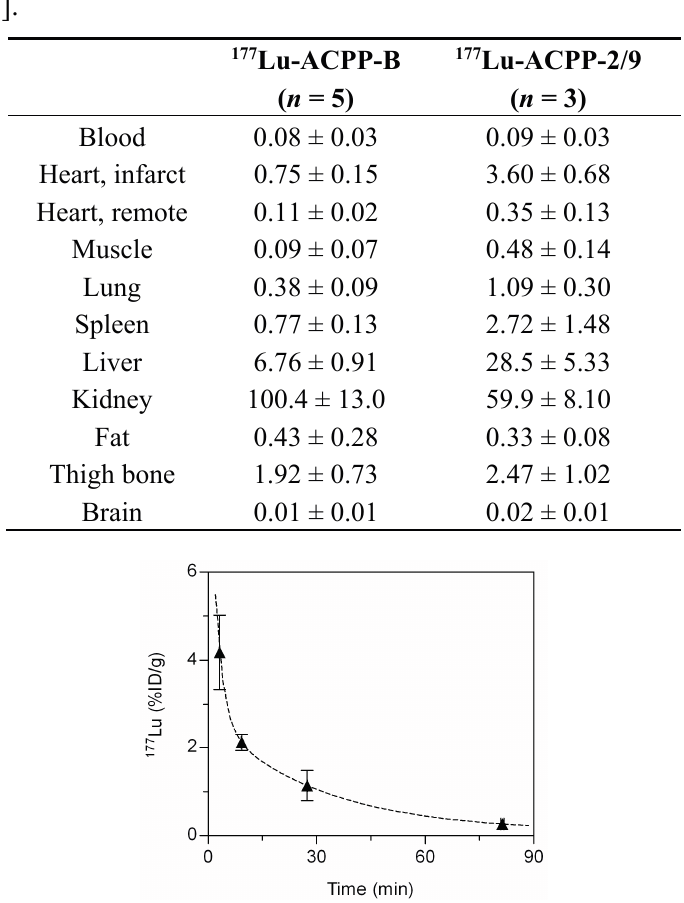
Figure 6. Blood kinetics of 177 Lu-ACPP-B in MI-mice ( n = 3). The data are mean %ID/g ± SD and fitted to the 2-phase exponential decay function Y = span 1 × exp( − K 1 × X) + span 2 × exp( − K 2 × X) + Plateau. Span 1 = 2.61%ID/g, K 1 = 1.99 min − 1 , Span 2 = 7.35%ID/g, K 2 = 27.1 min − 1